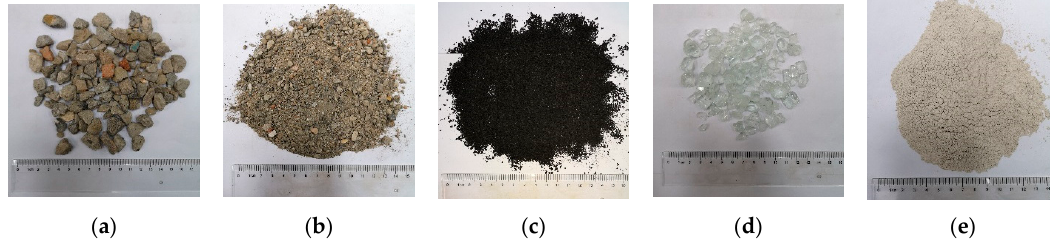
Table 1. Requirements of each property for different national codes